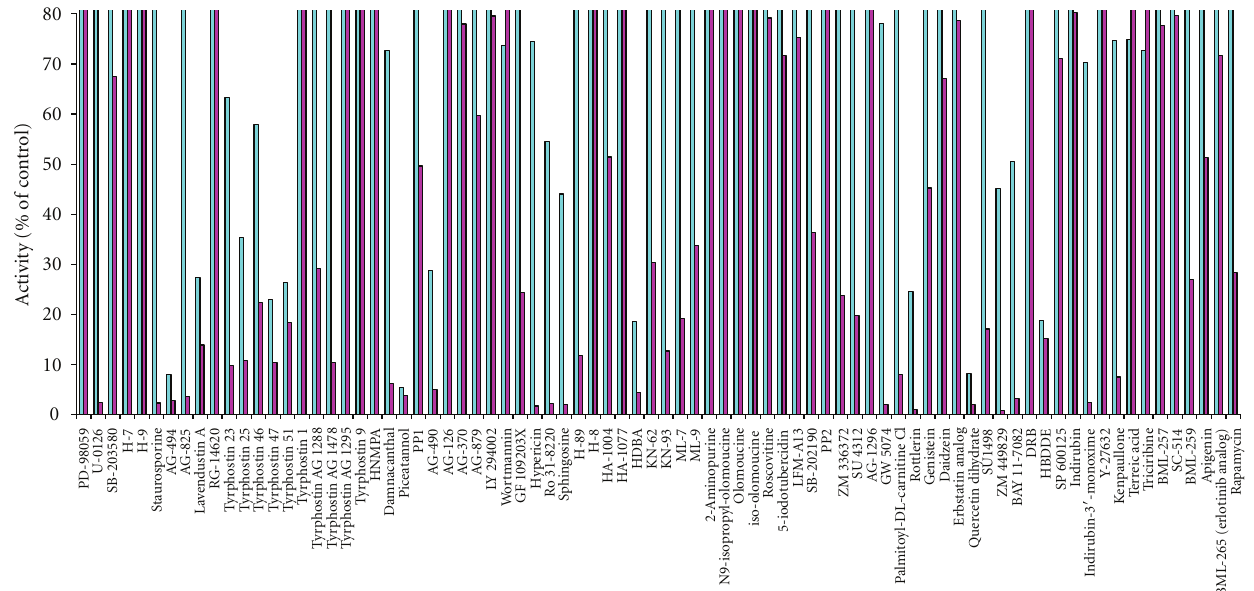
Figure 6: Influence of proteine kinase inhibitors on CERK via 96 well HTS. CERK was measured with NBD-C 6 -Cer in the presence of 0.5 mM of established protein kinase inhibitors (kinase inhibitor library, Biomol), using the 96 well fluorescent SPE assay. Activity is expressed as % of the control containing 10% DMSO (100 ± 11%; mean ± SD; n = 3, magenta bars). CERK was not influenced by DMSO, up to 20% (data not shown). For comparison, e ff ect of the inhibitors on sphingosine kinase is displayed in blue bars as % of control (100 ± 7%; mean ± SD; n =